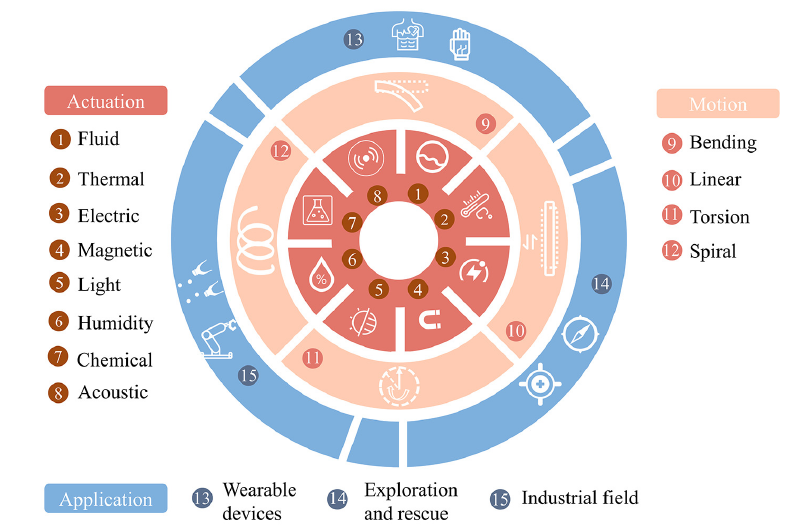
Figure 1. Actuation methods, motions, and applications of soft